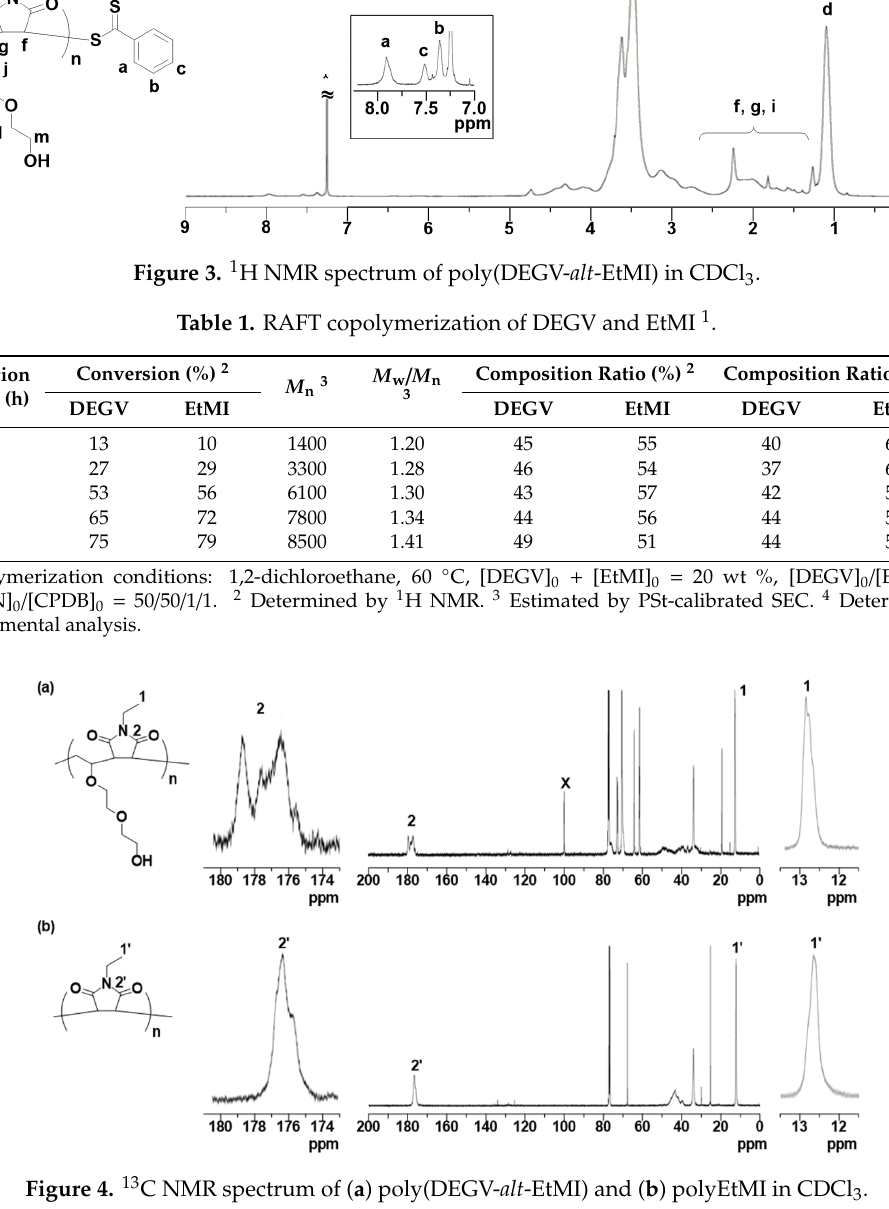
Figure 4. 13 C NMR spectrum of ( a ) poly(DEGV- alt -EtMI) and ( b ) polyEtMI in CDCl 3 . Table 1. RAFT copolymerization of DEGV and EtMI. 1